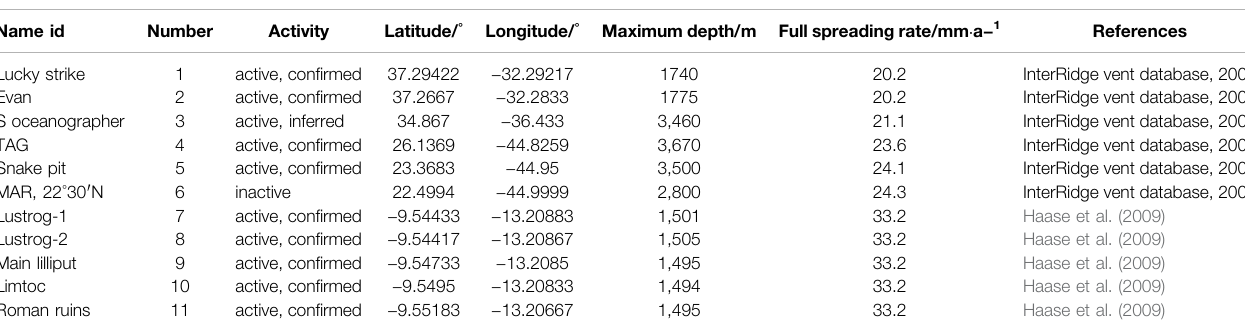
TABLE 1 | Hydrothermal vents of